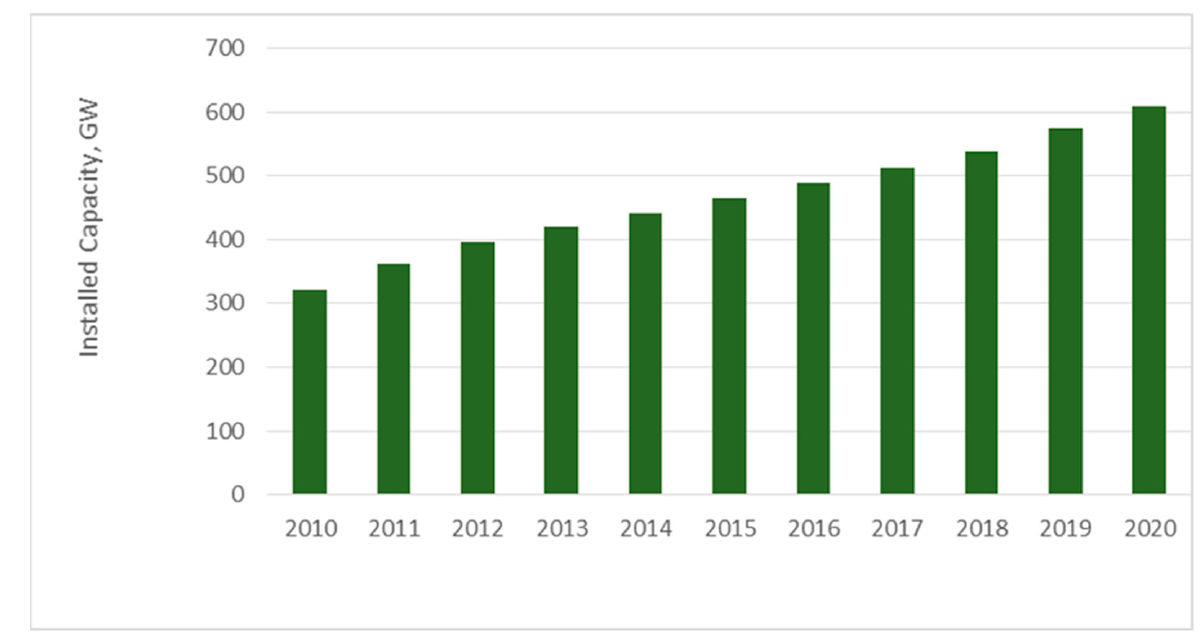
Figure 1. Dynamics of growth of the installed capacity of technologies for the use of renewable energy sources in Europe (IRENA).